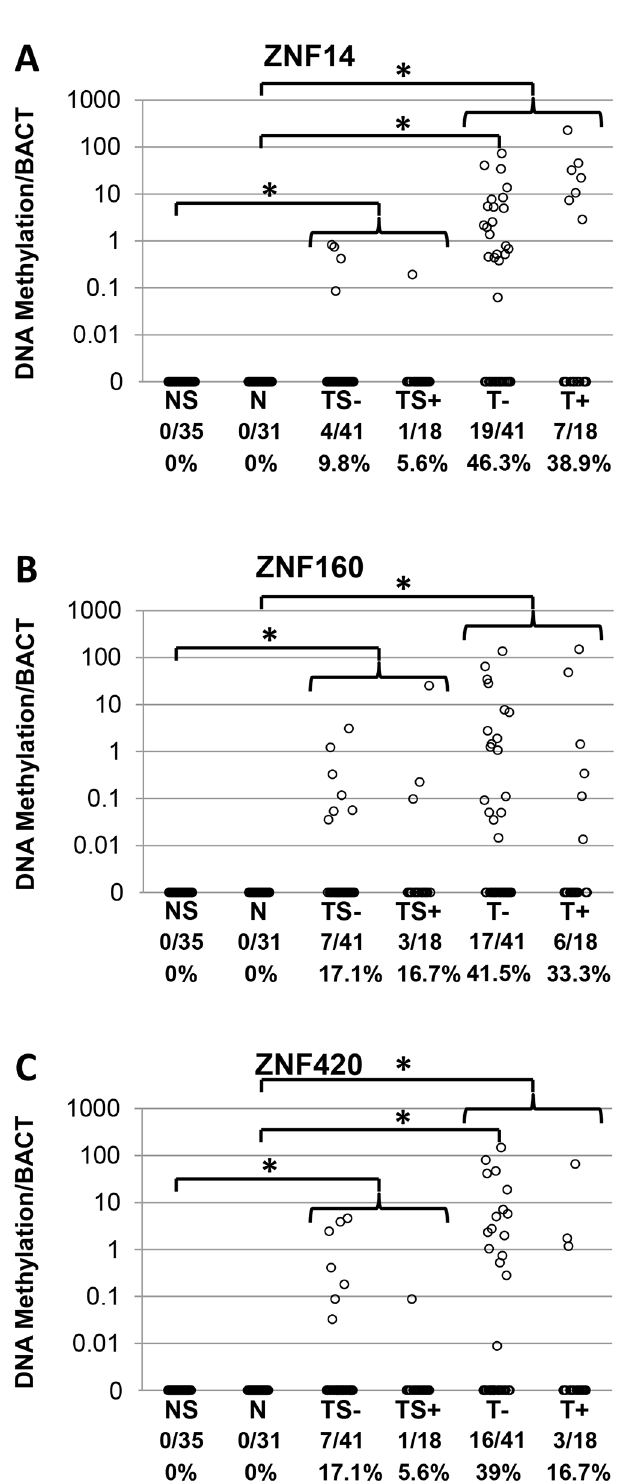
Fig 3. ZNF14 , ZNF160 , and ZNF420 DNA methylation detection in primary tissues and bodily fluids of HNSCC patients. Shown are ZNF QMSP results in 59 HNSCC primary tumor and salivary rinse samples compared to normal plasma and salivary rinse samples from the validation cohort. ZNF promoter methylation was quantified relative to BACT methylation and multiplied by 100. Plus (+) or minus (-) refers to their HPV